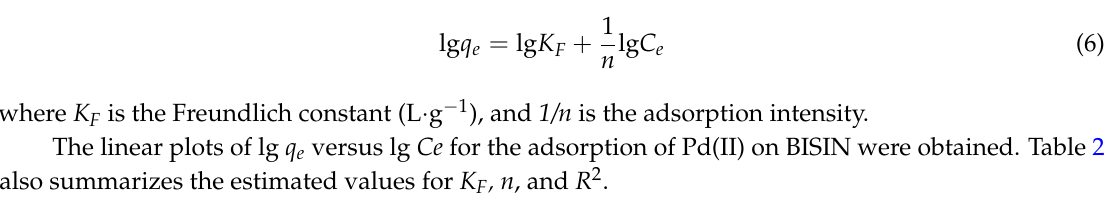
Table 2. Langmuir and Freundlich isotherm parameters of BISIN.